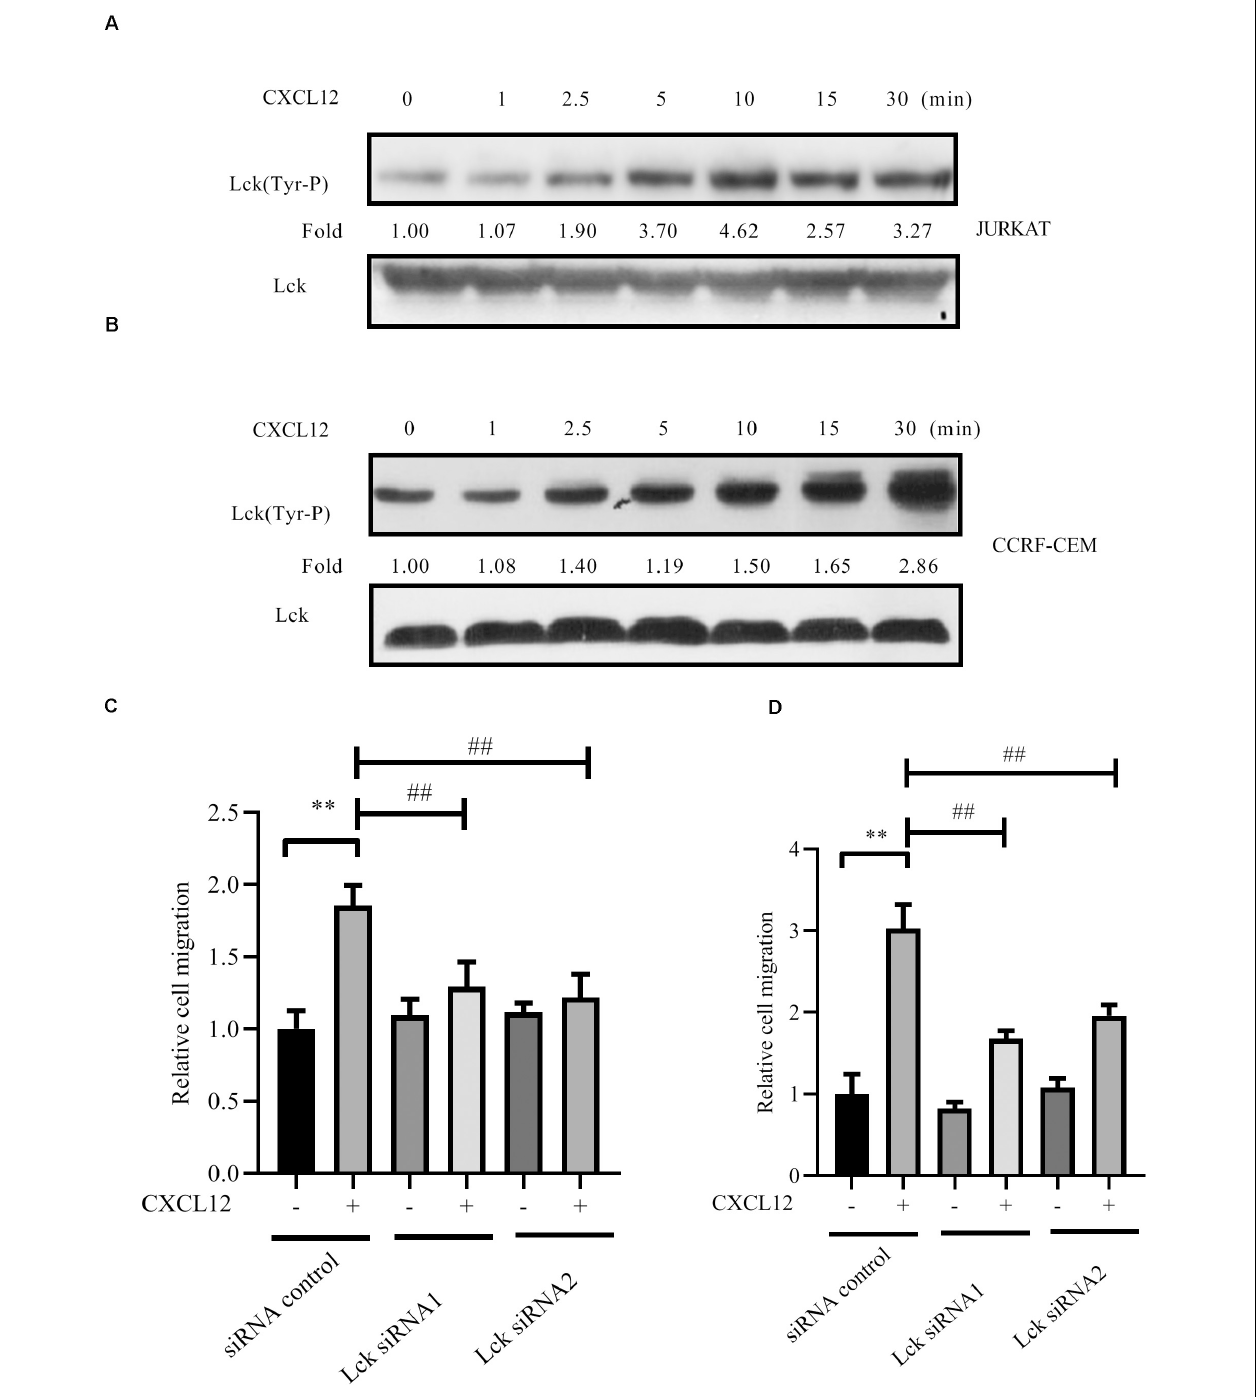
FIGURE 8 | Lck was activated by CXCL12 and knocked down the expression of Lck by siRNA-inhibited CXCR4-mediated T-ALL migration toward CXCL12. (A,B) Starved JURKAT or CCRF-CEM cells were incubated with CXCL12, and then cell lysates were prepared: 60 µ g of cell lysates were subjected to SDS-PAGE and Western blot assay, using active Lck antibody, Lck (394 Tyr-P). Western blot bands were analyzed using Image Pro Plus 6.0, and fold changes of active Lck were normalized according to total Lck. Total ABL1 was used as another loading control. (C,D) siRNAs were transfected into JURKAT or CCRF-CEM cells using the methods described in the materials and methods section; 48 h after transfection, cells were used in the transwell assay. Each experiment was repeated at least three times, and three repeats were included each time. ** p < 0.01 comparing with the negative control (CXCL12 − ) group. ## p < 0.01 comparing with the positive control (CXCL12+)